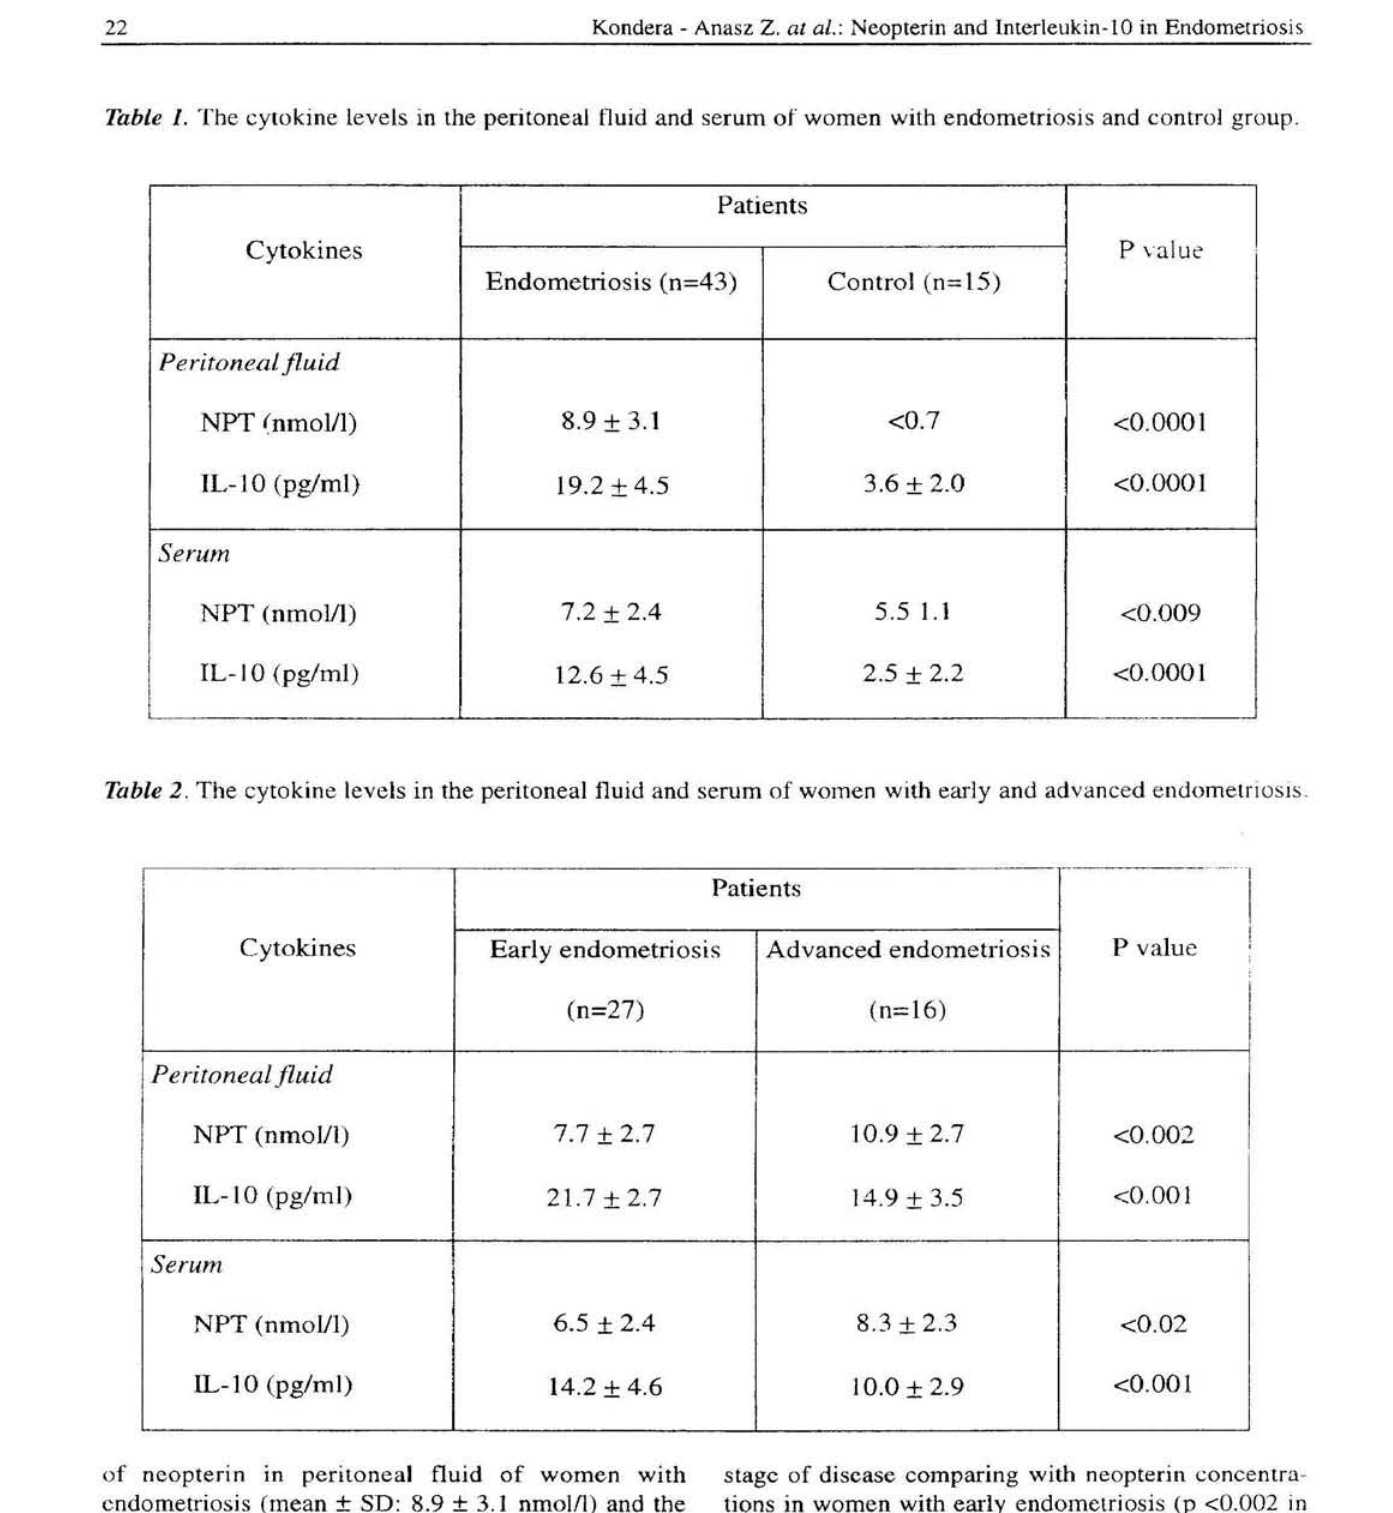
Table l. The cytokine levels in the peritoneal fluid and serum of women with endometriosis and control group.